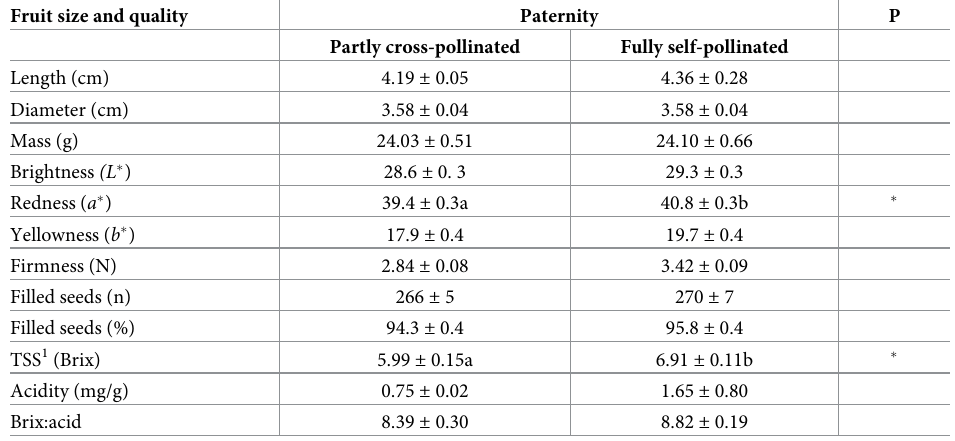
Table 3. Size and quality of partly cross-pollinated and fully self-pollinated fruit of Red Rhapsody strawberry. Fruit size and